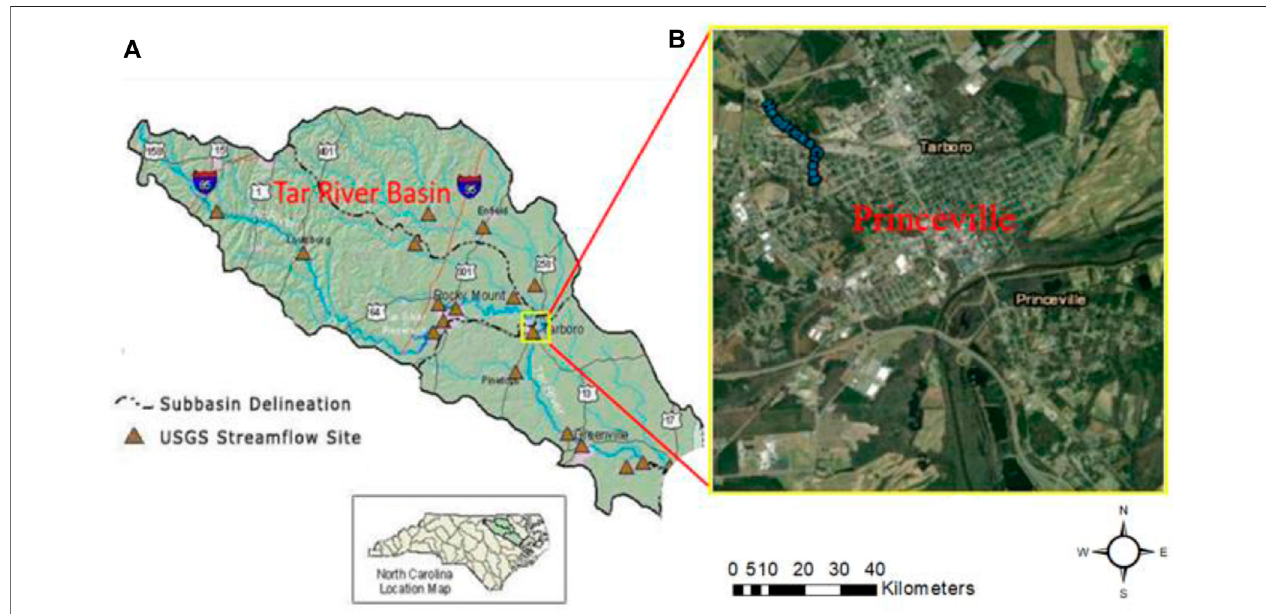
FIGURE 3 | Study area: Princeville. (A) The area used to calculate the GFI — Tar River Basin; (B) The study area used for inundation depth calculation for deep learning approach.